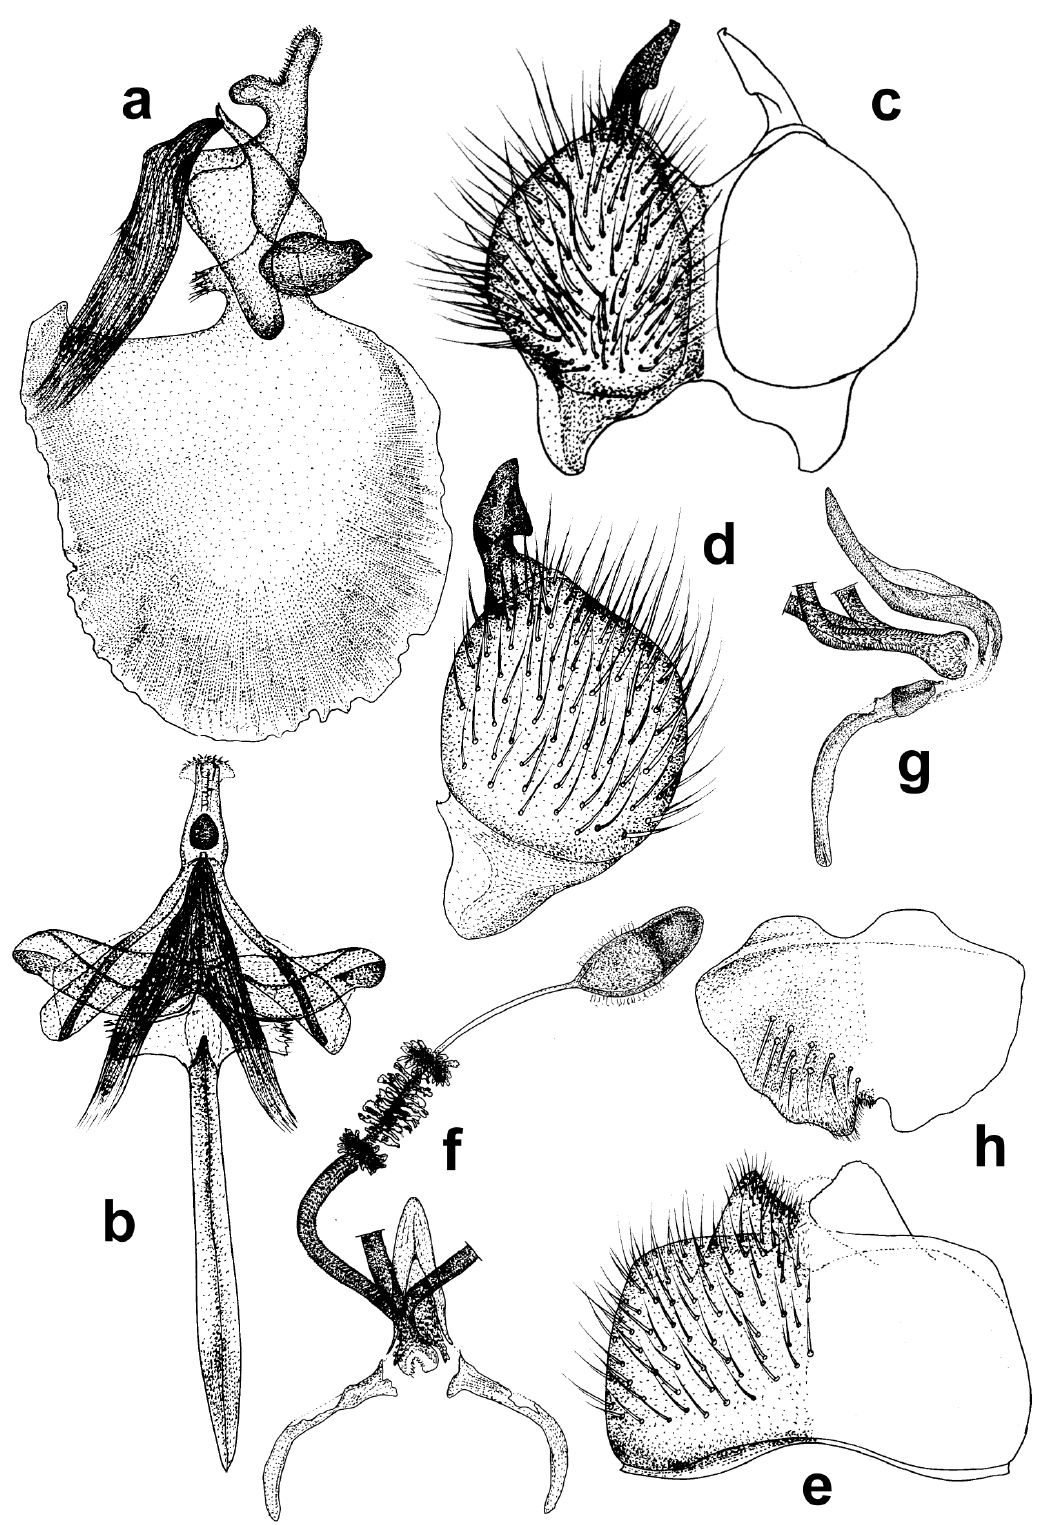
Fig. 62. Parusia benoisti gen. et sp. nov. a . Epiphallic complex ventral. b . Epiphallic complex lateral. c . Gonocoxite ventral. d . Gonocoxite lateral. e . Epandrium dorsal. f . Female genitalia ventral. g . Female genitalia lateral. h . Female sternite 8